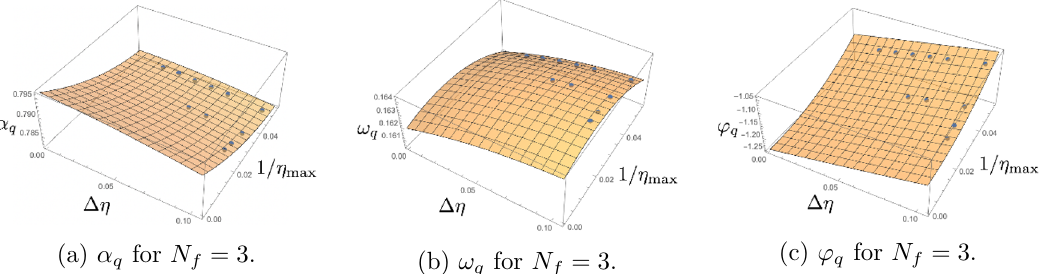
(c) ’ q for N f = 3. (a) (cid:11) q for N f = 3. (b) ! q for N f = 3. Figure 10 . Plots of parameters (cid:11) q , ! q and ’ q as functions of (cid:1) (cid:17) and 1 =(cid:17) max for N f = 3 and N c = 3. The dots represent our numerical evaluation, while the solid surfaces depict the best (cid:12)ts (quadratic in (cid:1) (cid:17) and 1 =(cid:17) max ) used for extrapolating to the continuum asymptotic values at (cid:1) (cid:17) = 0 and 1 = (cid:17) max